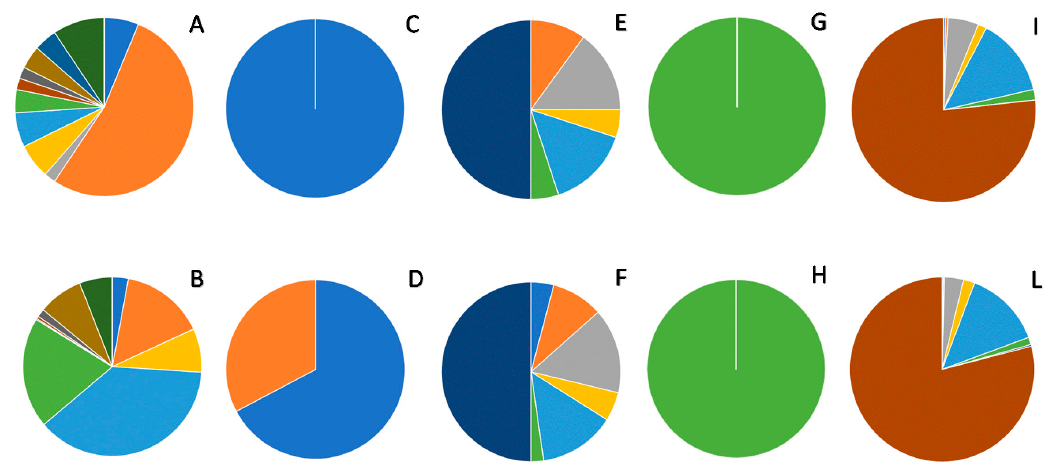
Figure 2. Pie diagrams showing the percentage distribution of selected classes of compounds in humic substances (HSs) ( A , C , E , G , I ) and soil water soluble phenolics (SWSP) ( B , D , F , H , L ) at a glance. ( A , B ) Phenolic acids: from benzoic (orange) to right ‐ handed cinnamic (grey), salicylic (yellow), syringic (heavenly), ferulic (green), o ‐ coumaric (blue), m ‐ coumaric (red), p ‐ coumaric (dark gray), protocatechuic (brown), caffeic (blue), p ‐ hydroxybenzoic (dark green), gentisic (light blue); ( C , D ) Aldehydes: vanillin (heavenly), syringaldehyde (orange); ( E , F ) Carbohydrates: from arabinose (blue) to right ‐ handed glucose (orange), galactose (grey), glucuronic acid (yellow), mannose (heavenly), galacturonic acid (green), total sugars (dark blue); ( G , H ) Organic acids: tartaric acid (green); ( I , L ) Fatty acids: myristic (blue, not visible in the pie diagram), palmitoleic (orange, not visible), palmitic (grey), linoleic (yellow), oleic (heavenly), stearic (green), arachidic (dark blue, not visible), total lipids (brown). From this figure one can see at a glance how the phenolic composition differs well in its pattern between HSs and SWSP. In the former there is a clear prevalence of benzoic (orange), while in the latter approximately 75% of the total is given by syringic (heavenly), ferulic (green) and benzoic (orange). Carbohydrates and lipids, while showing different absolute values, give instead a similar percentage composition.